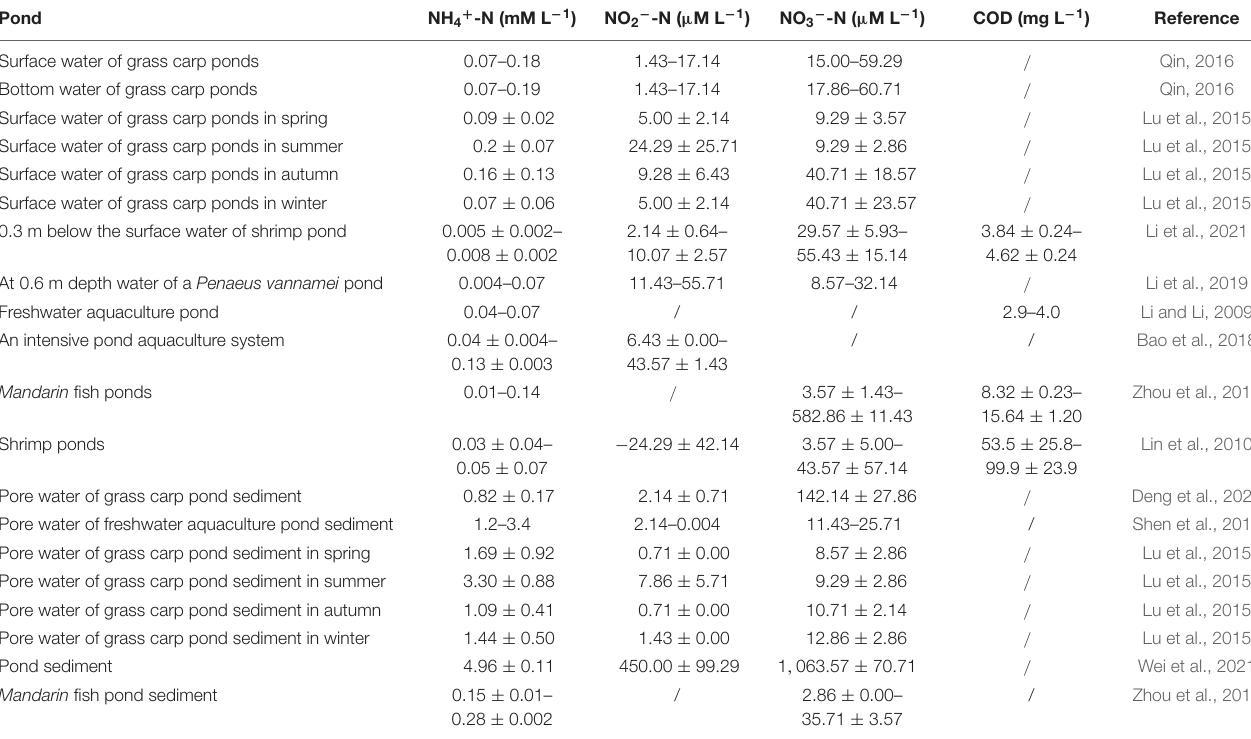
TABLE 2 | Characteristics of pond aquaculture water and pore water of